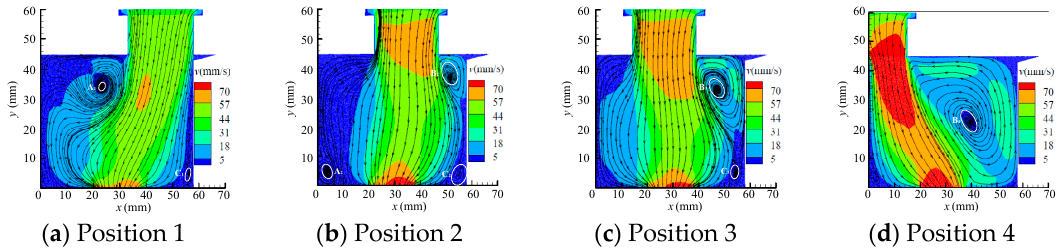
Figure 6. Velocity contours and streamlines with a pump inlet flow of 750 mL/min.